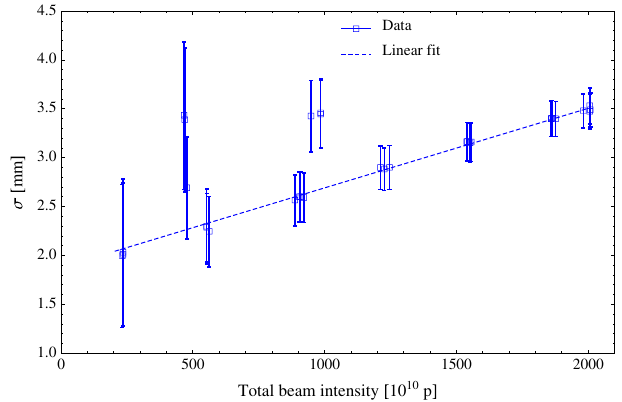
FIG. 6. Horizontal beam size before resonance crossing as a function of the total beam intensity. The linear dependence is clearly visible and is due to the multiturn injection process in the PS booster. The outliers represent the cases in which the number of injected bunches has been reduced, hence, the transverse emittance remains constant while the total beam intensity is decreased. The number of injected bunches can be controlled by inhibiting the proton beam injection into one or more PSB rings. The nonzero constant term of the linear relationship indicates that an emittance blowup is occurring, very likely at PS